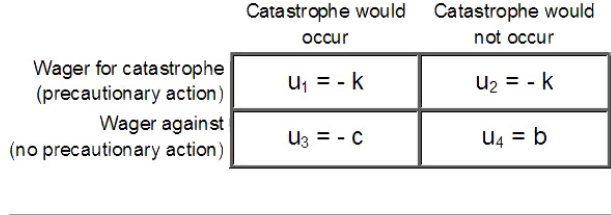
Fig. 3 . Payoff matrix assuming that an ecological catastrophe would result in a large, but finite, negative cost (-c). The cost associated with taking precautionary action is –k. The payoff if no precautionary action is taken and no catastrophe occurs is b, which could be positive or negative, but is often assumed to be a positive